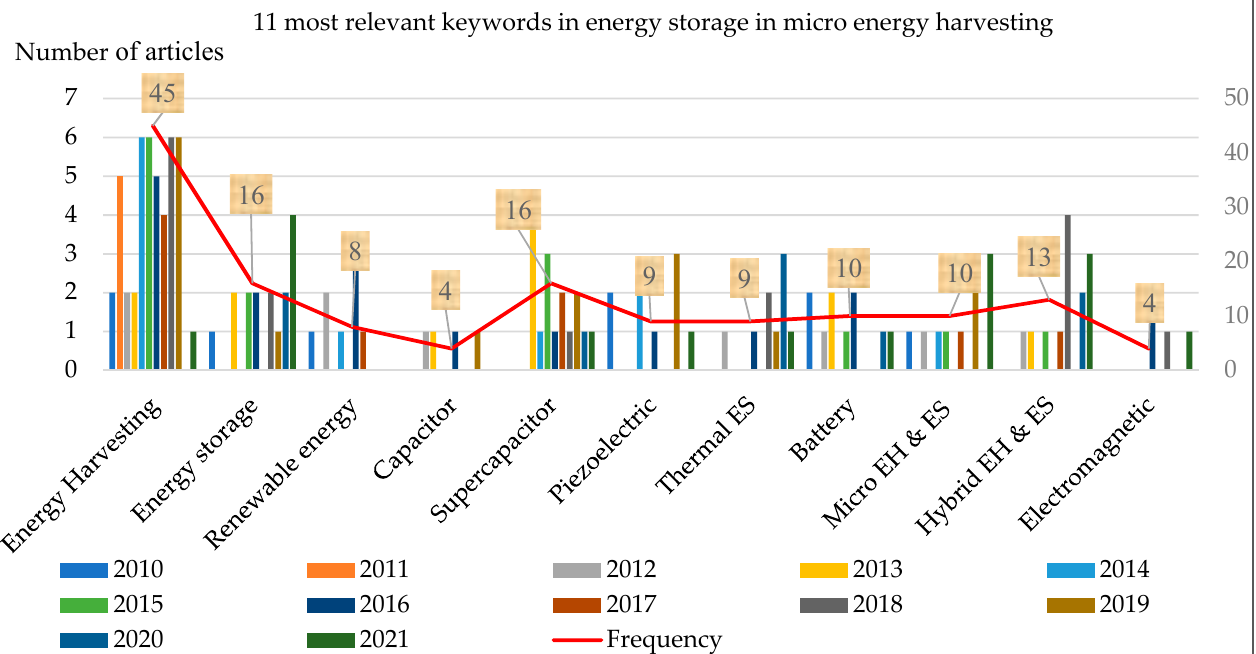
Figure 5. Presentation of 11 most relevant keywords from 2010 to 2021.